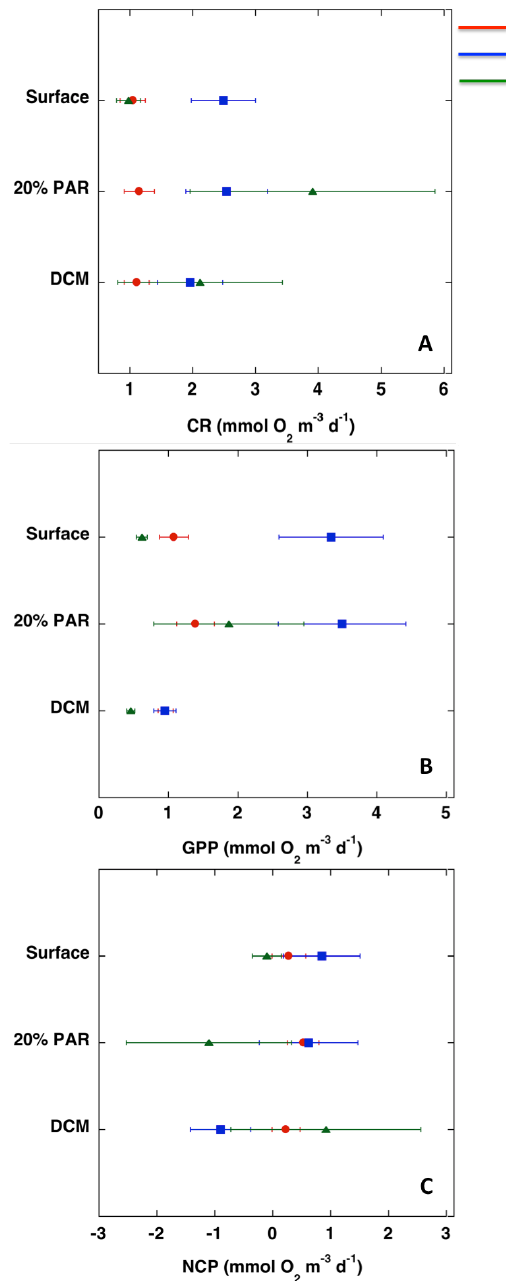
Figure 6. Mean ± SE for (a) community respiration (CR), (b) gross primary production (GPP) and (c) net community production (NCP) (mmolO 2 m − 3 d − 1 ) for each season (winter, spring and summer) at the three sampled depths (surface, 20%PAR and